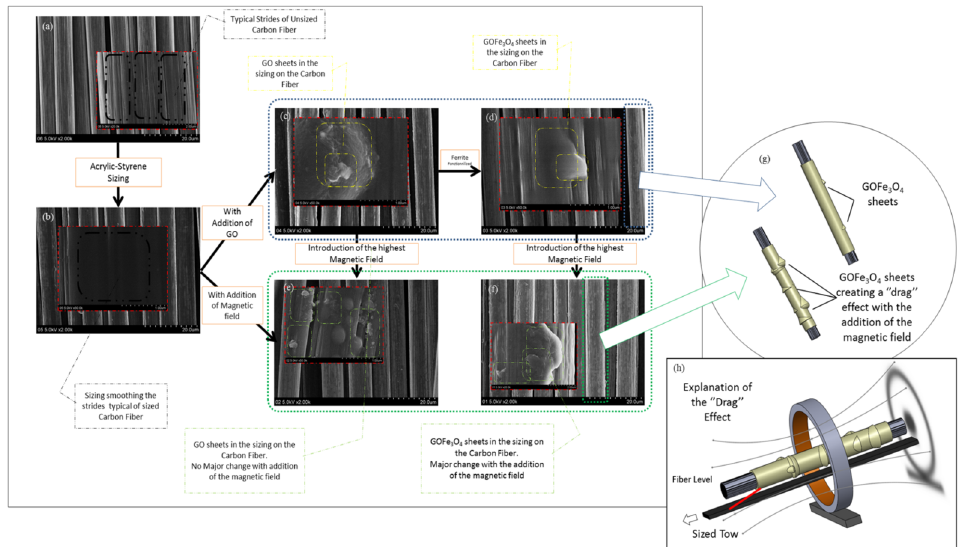
Figure 8. Effect of magnetic field on the coating quality of the fibers using ( a ) FESEM image of unsized fiber ( b ) FESEM image of fiber sized with the acrylic-styrene only ( c ) FESEM image of fiber sized with the acrylic-styrene with GO ( d ) FESEM image of fiber sized with the acrylic-styrene with GOFe 3 O 4 ( e ) FESEM image of fiber sized with the acrylic-styrene with GO and magnetic field; ( f ) FESEM image of fiber sized with the acrylic-styrene with GOFe 3 O 4 and magnetic field; ( g ) schematic drawing of